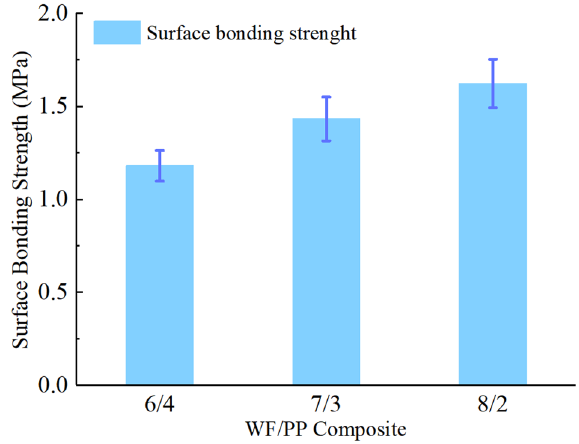
Figure 6. The surface bonding strength of the wood veneered WF/PP composites.